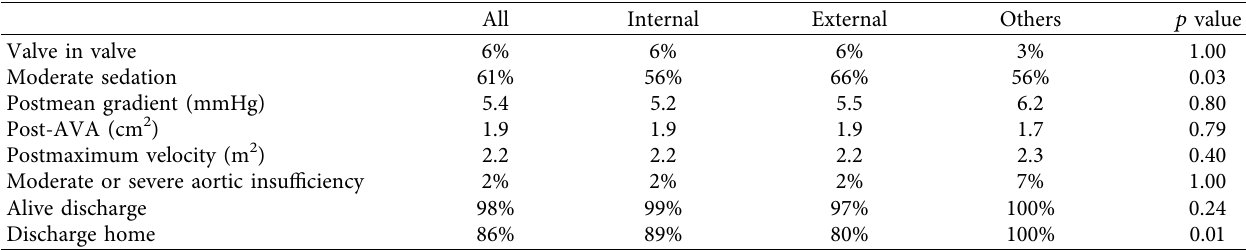
Table 2: Procedural outcomes of 491 consecutive patients undergoing TAVR. All